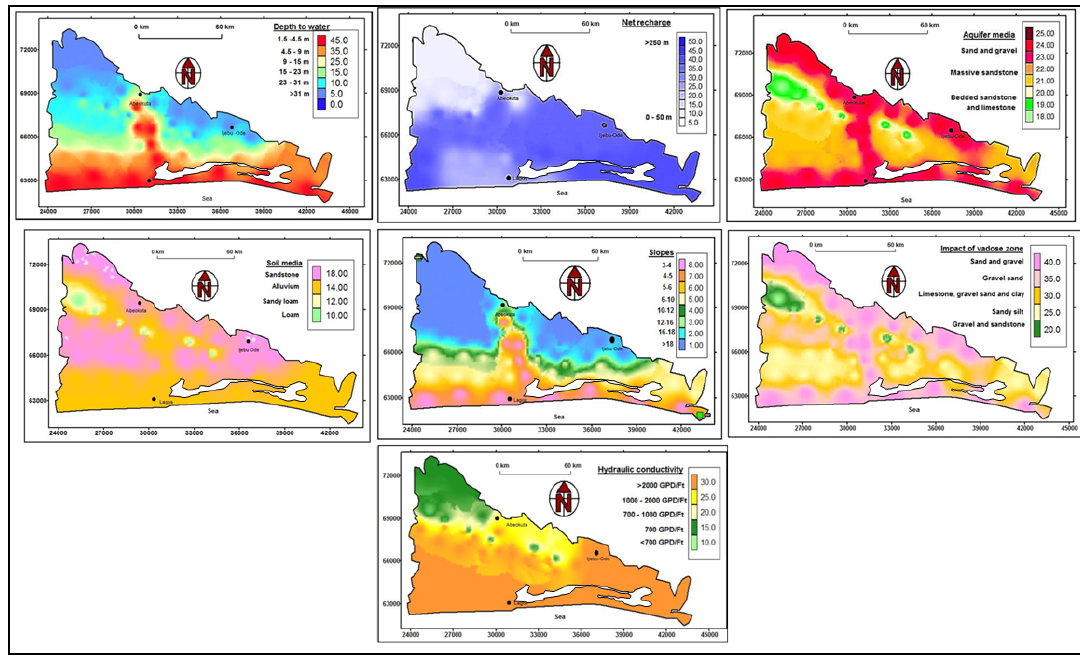
Figure 4. Maps of the seven DRASTIC parameters.